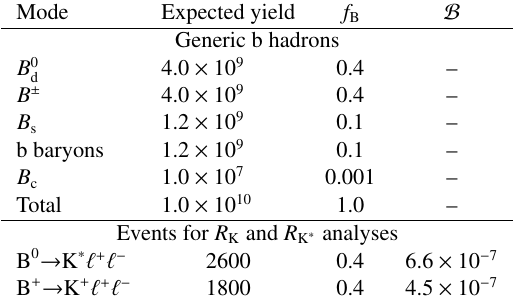
Table 2. Summary of the expected yields for important signal-side b hadron production (and decay) modes in the B parking data sample. The quoted yields are based on the same assumptions used to evaluate Equation 2 in Sec. 2, and do not account for A (cid:15) . The branching fraction B is stated where appropriate, and f B is defined in the text (Sec. 2). Table contents taken from Ref.